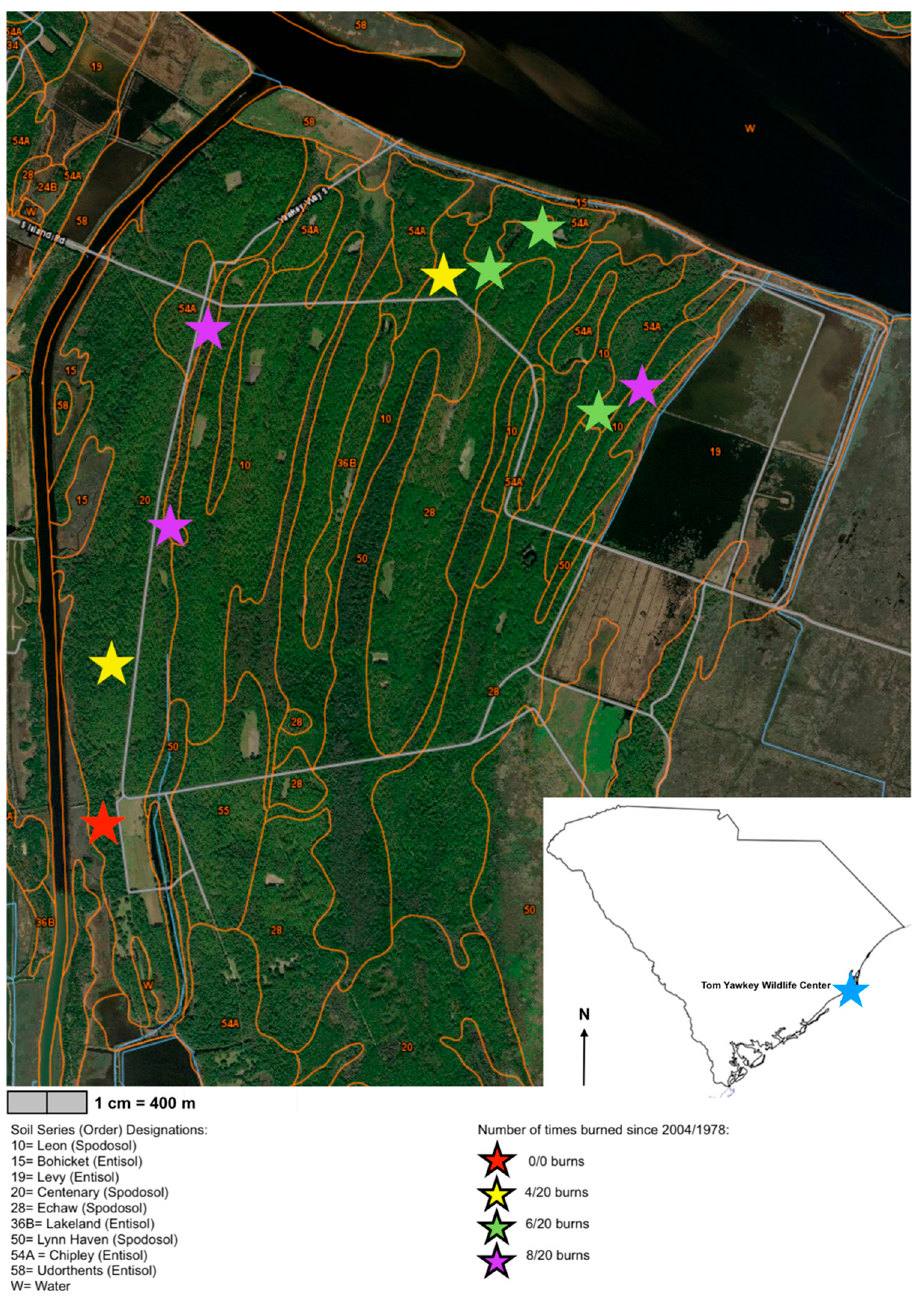
Figure 1. Location of the Tom Yawkey Wildlife Center, Georgetown, SC, USA (33.23°N, − 79.22°W) and the spatial orientation of soil sampling transects (every 50 m), associated soil series designations, and the number of times burned since 2004/1978.